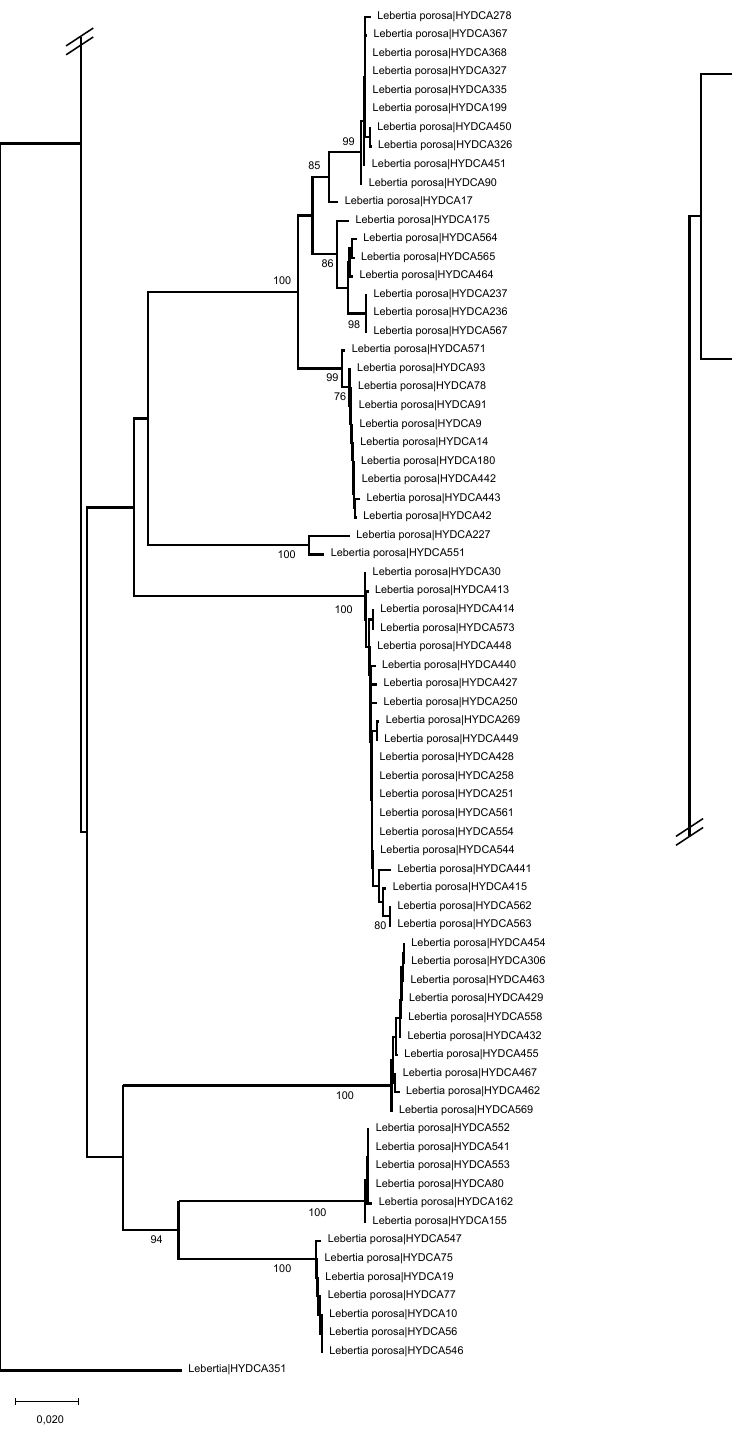
Fig. 2. Neighbor Joining tree based on COI barcodes of Norwegian specimens in the Lebertia porosa aggr. using the Kimura 2-Parameter substitution model. Bootstrap support (1000 replicates) above 70% is shown on